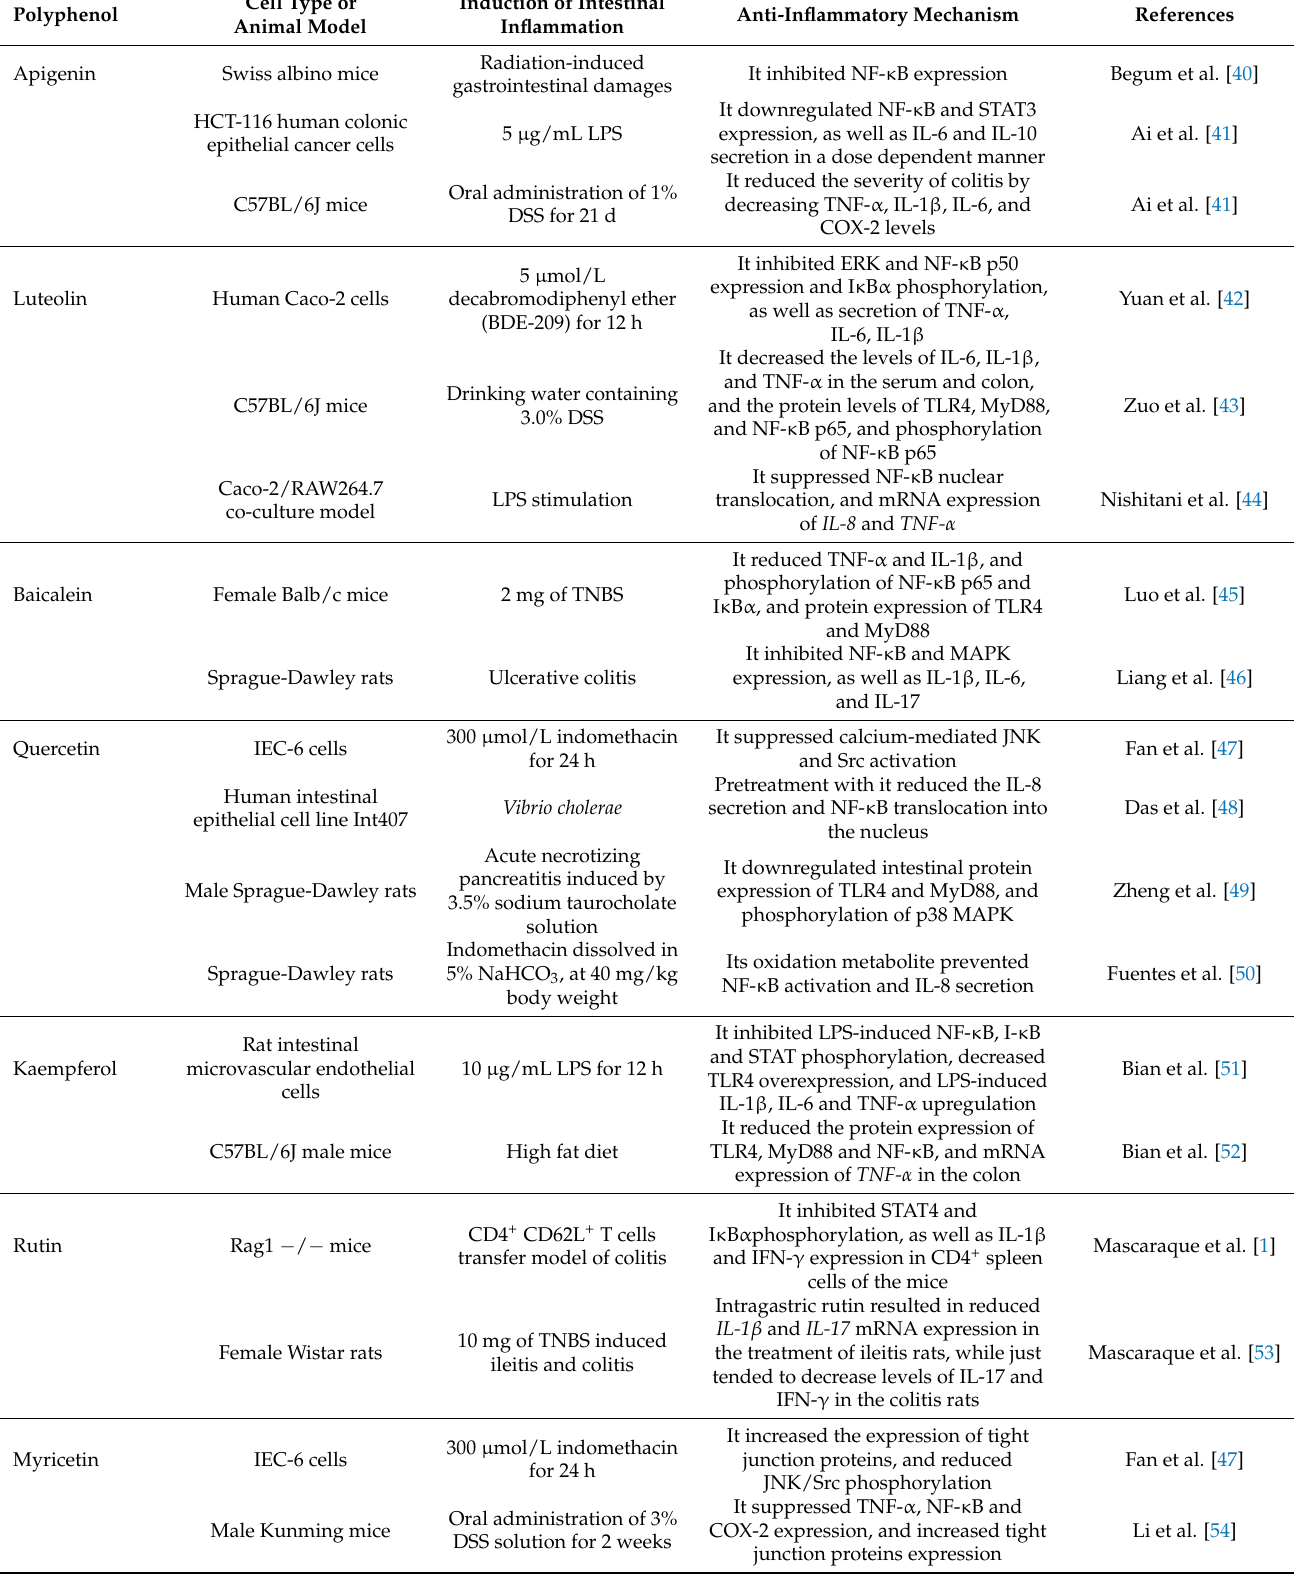
Table 1. Summary of polyphenols’ effects on intestinal inflammatory diseases along the TLR4/NF- κ B-mediated signaling pathway in vitro and in